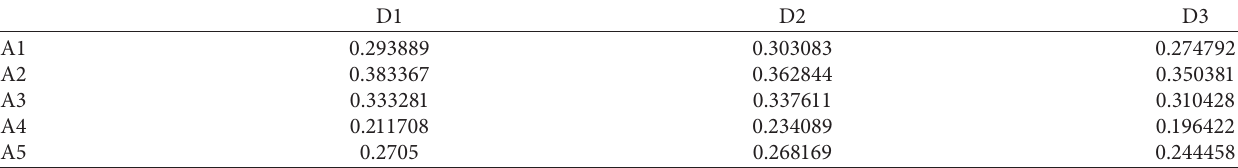
Table 12: Defuzzification